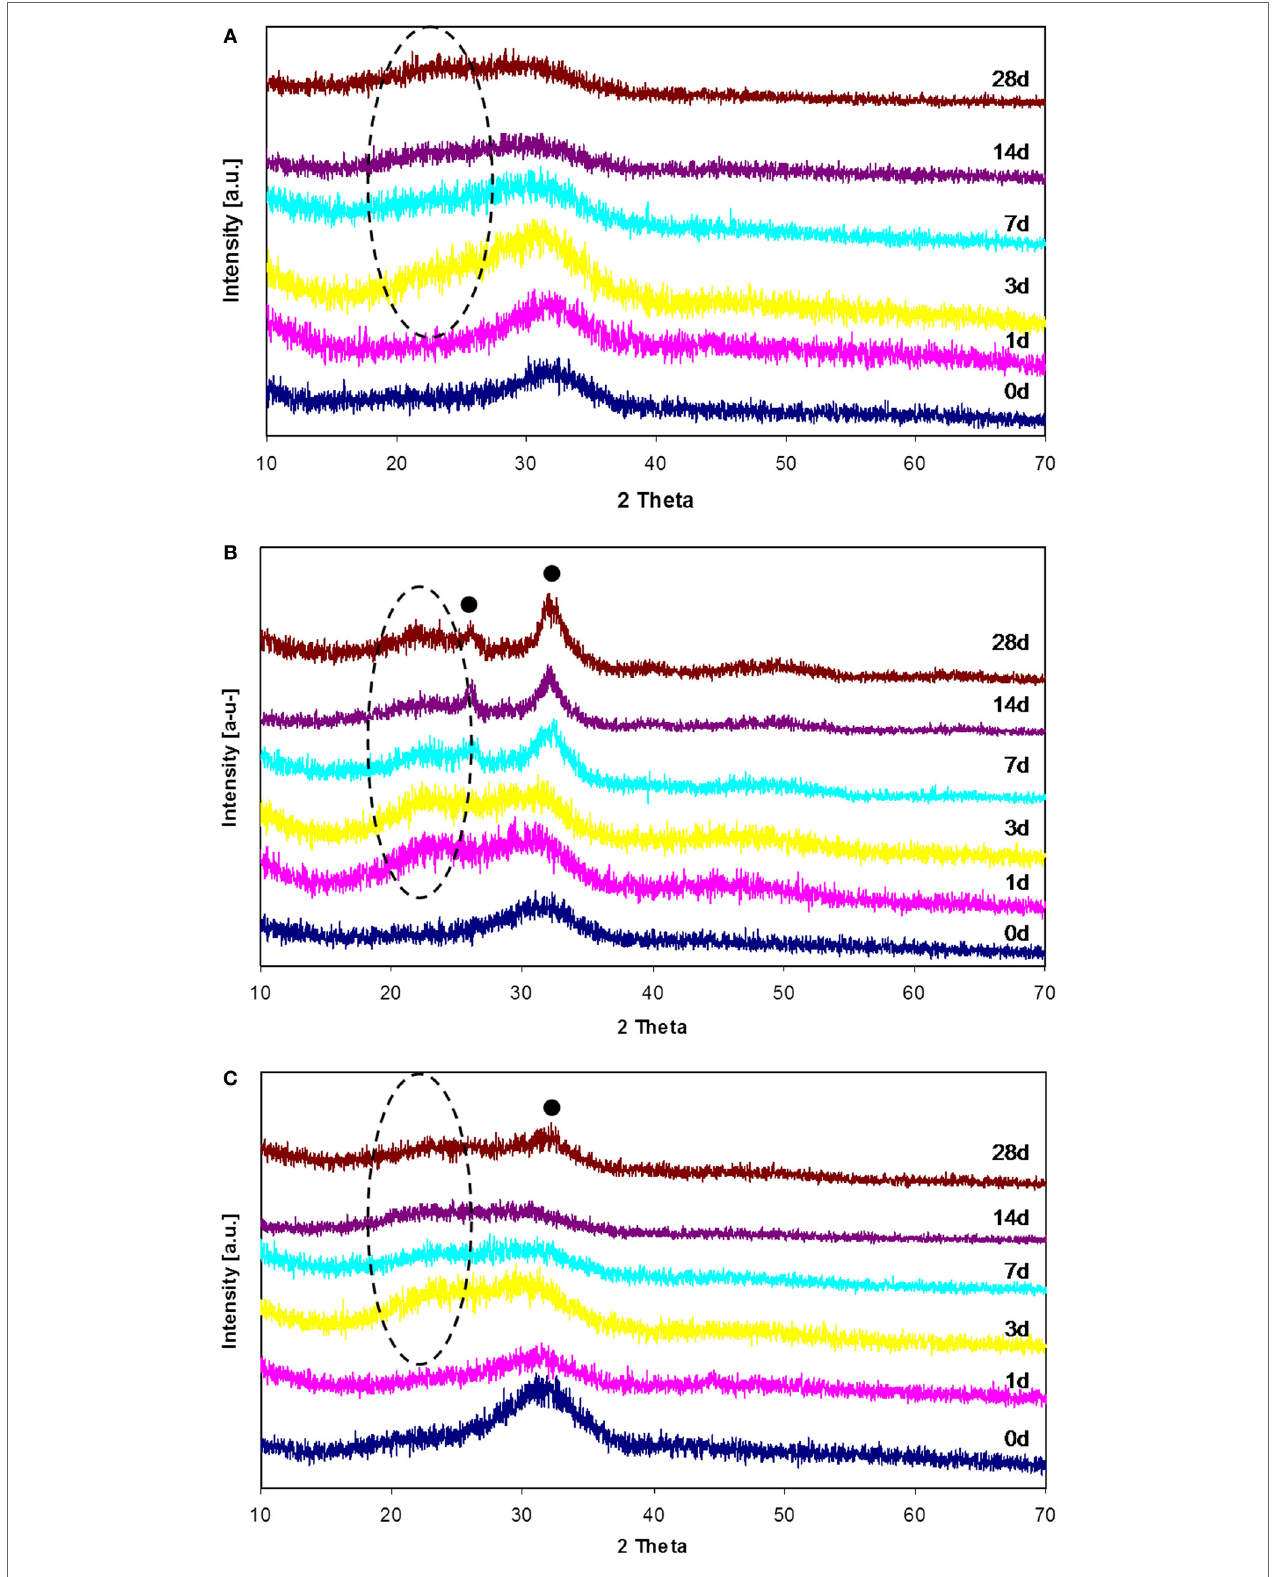
FigUre 1 | XrD patterns of 45s5-Zn (a), 45s5-sr (B), and 45s5-Znsr (c) before and after sBF treatment up to 1 month . (•) Hydroxyapatite, (–) silica gel.